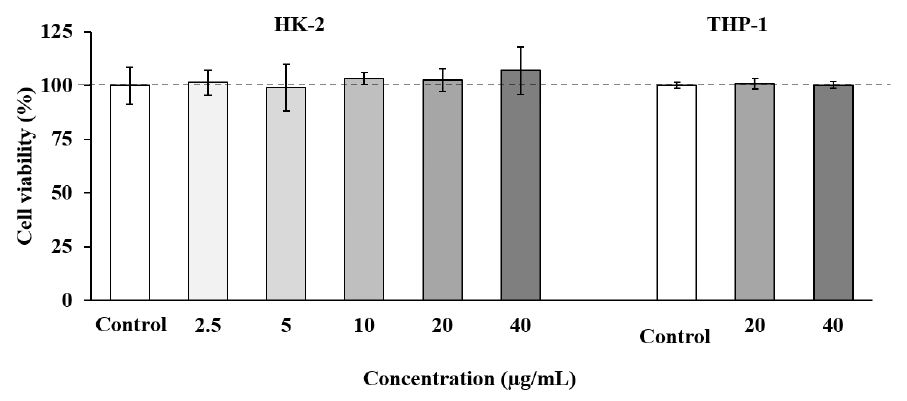
Figure 3. Tubular epithelial cells (HK-2) and human THP-1 monocytes cell viability upon treatment for 24 h with different concentrations of SS adsorbate from olive leaves. Error bars are given as the standard deviation of three independent experiments.